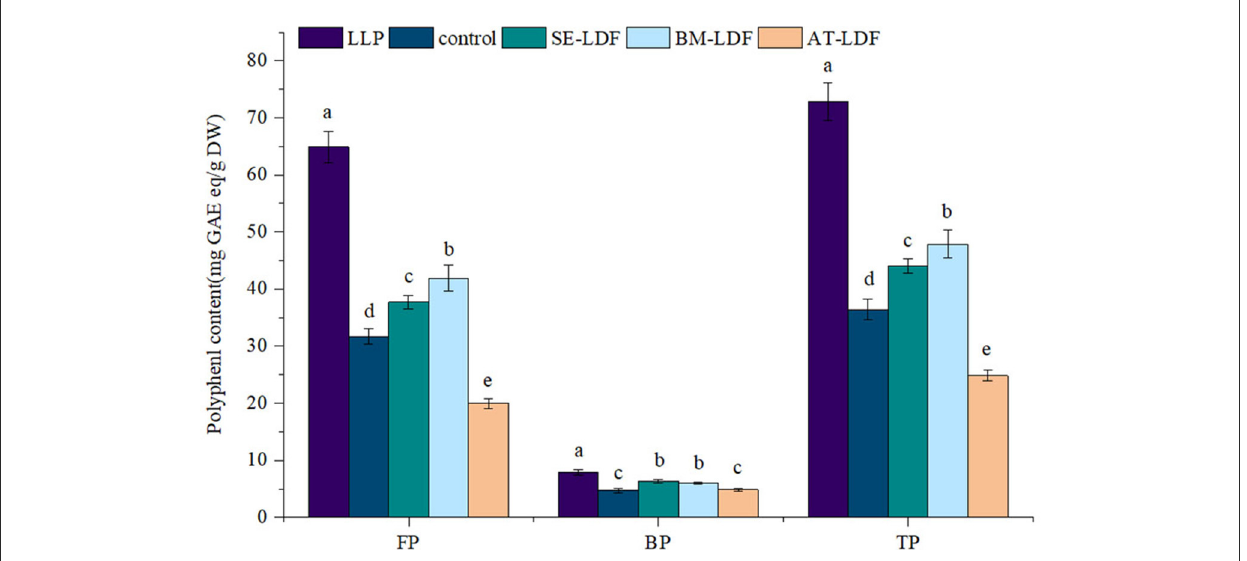
FIGURE5 Polyphenol content of FP, BP, and TP in LLP and LDF. All values were means ± sd, n = 3. Values with different letters were significantly different in the same group; P < 0.05. FP, free phenolic; BP, bound phenolic; TP, total phenolic; LLP, lotus leaves powder; control, lotus leaves dietary fiber; SE-LDF,